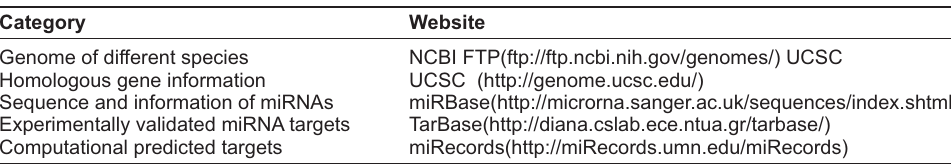
Table-2. Online resources for miRNA target prediction